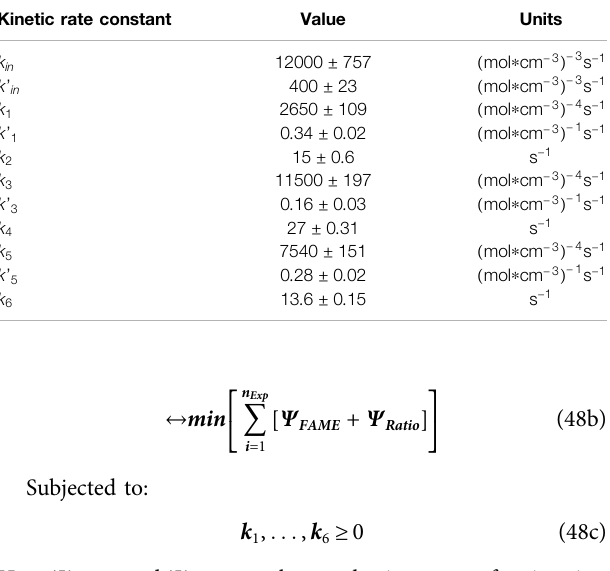
TABLE 4 | Values of kinetic rate constants and con fi dence intervals ( α ≥ 95%). Kinetic rate constant